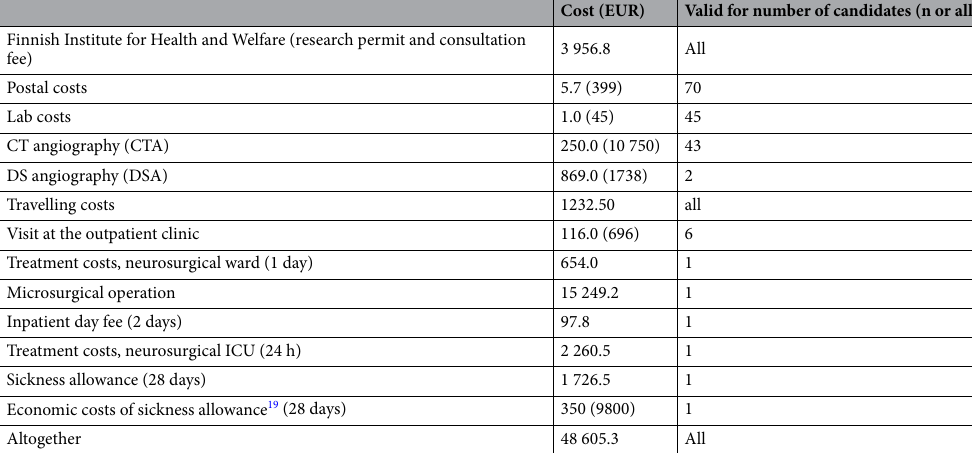
Cost (EUR) Valid for number of candidates (n or